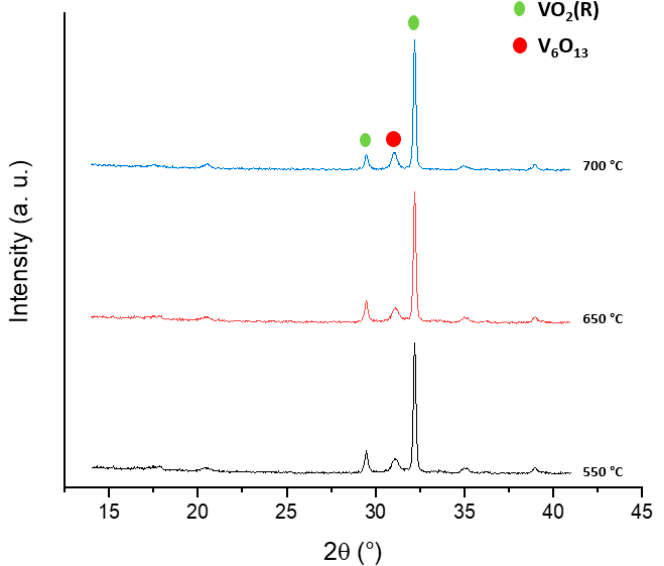
Figure 4. Superimposition of the XRD patterns of V5 1.7 _12h sample annealed at 550 ◦ C, 650 ◦ C, and 700 ◦ C (Co anode).